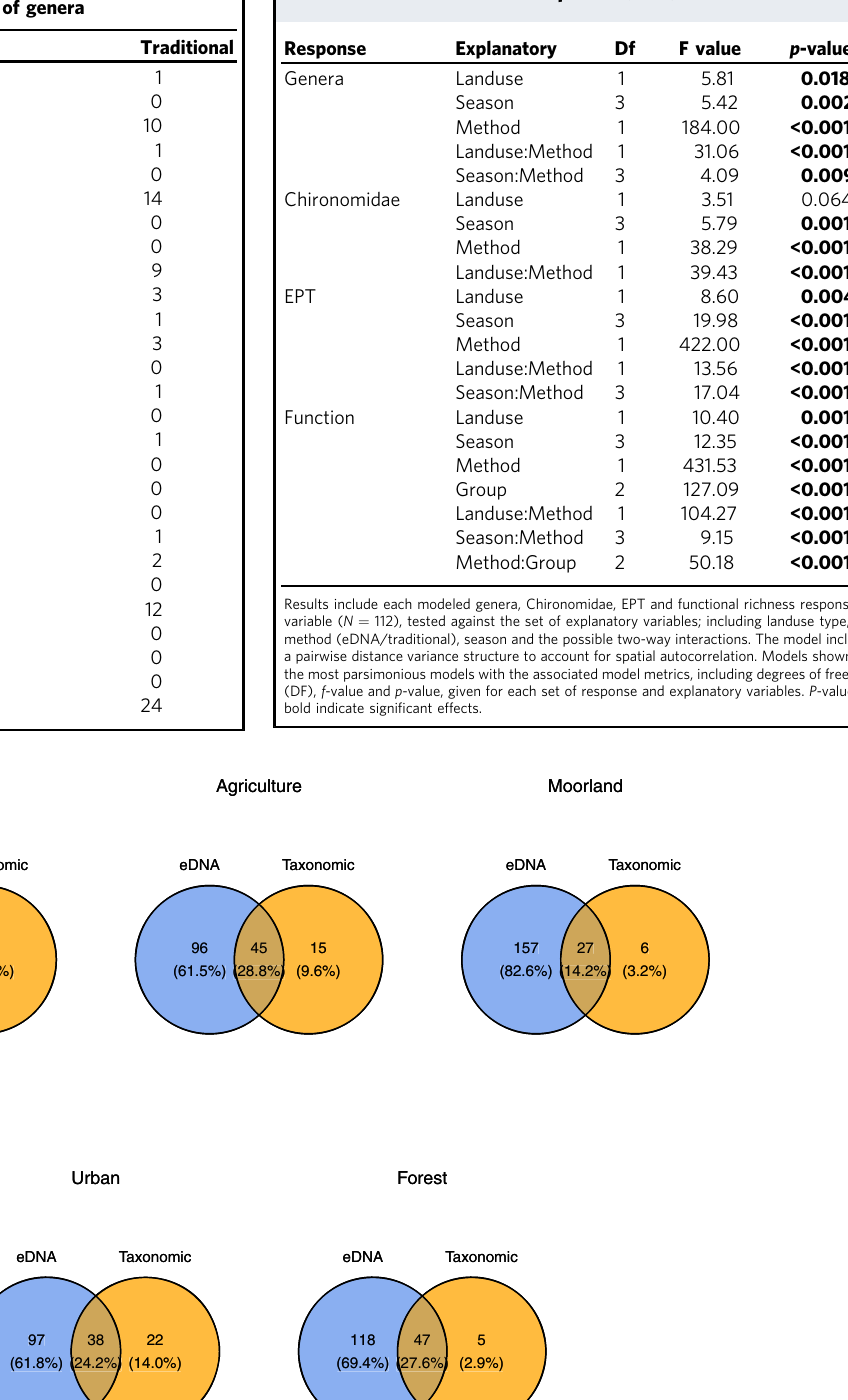
Table 3 Generalized least squares (GLS) statistics.